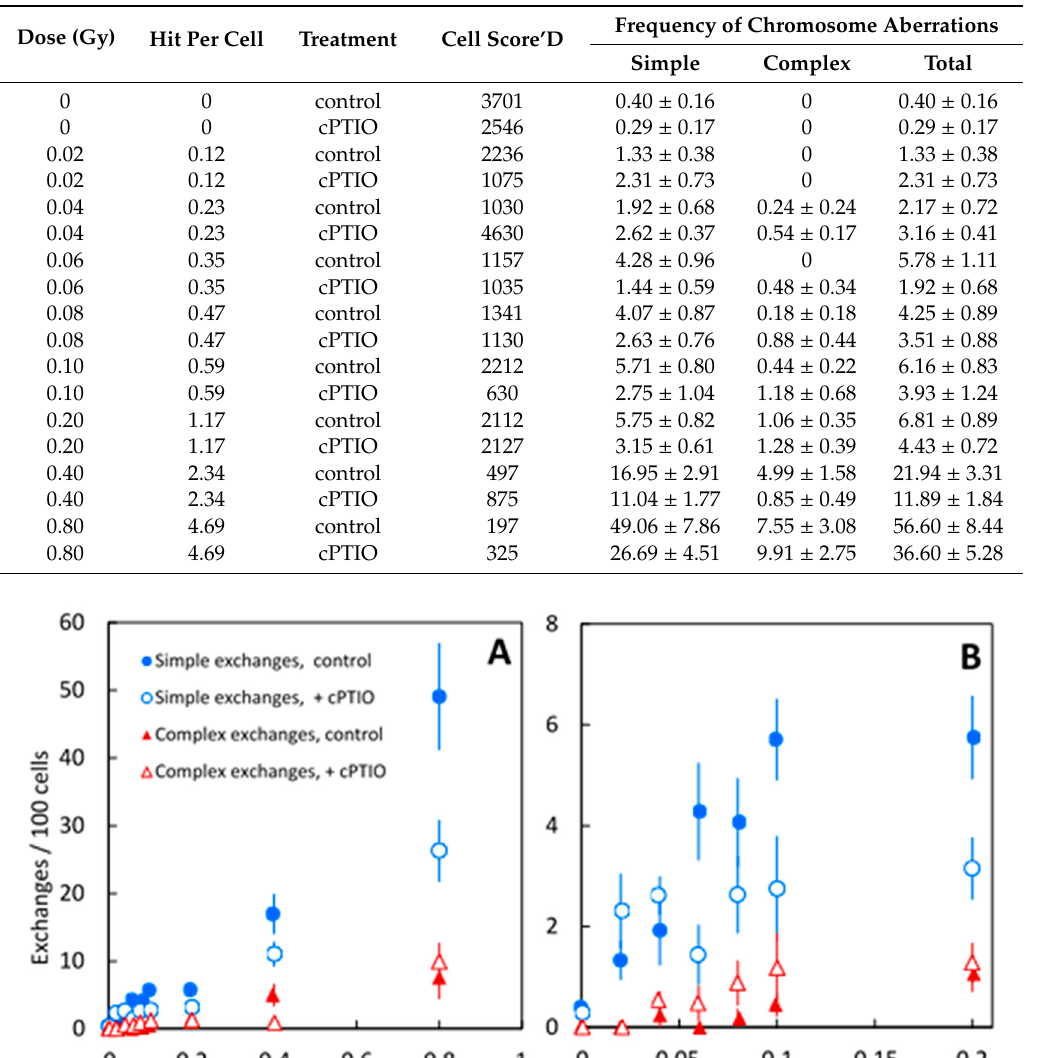
Table 2. Whole genome equivalent for frequency of CA per 100 cells exposed to Fe ions (600 MeV / u) with and without cPTIO.